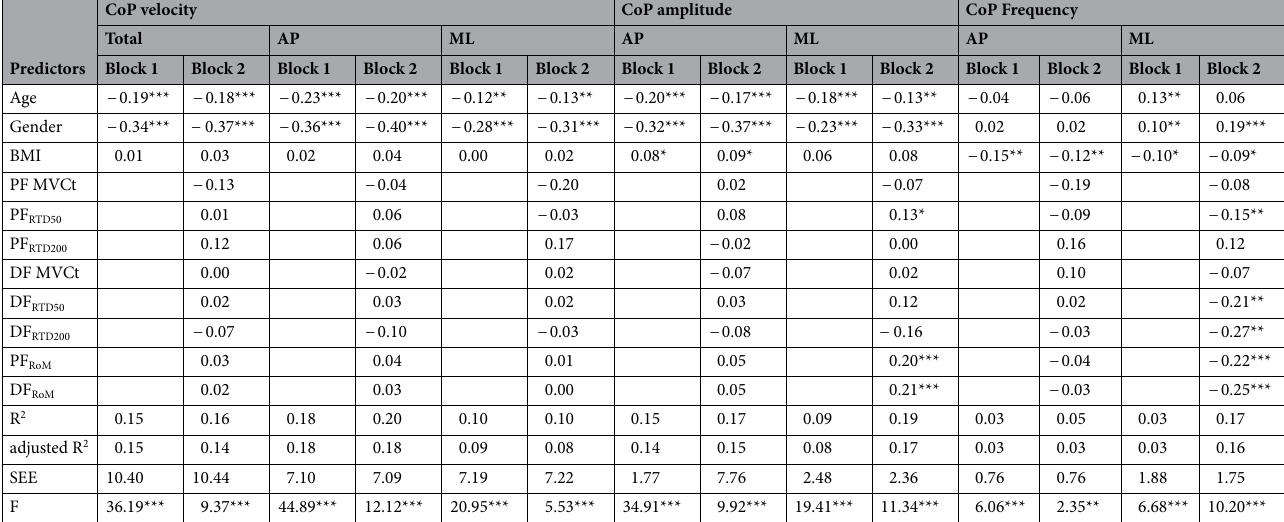
Table 4. Sequential linear regression models of body sway variables. Values are standardized regression coefficients from linear regression analysis. 1 = males; 2 = females. AP anterior–posterior, ML medial–lateral, BMI body mass index, PF MVCt maximal voluntary contraction torque for plantar flexion, PF RTD50 plantar flexion rate of torque development for 0–50 ms, PF RTD200 plantar flexion rate of torque development